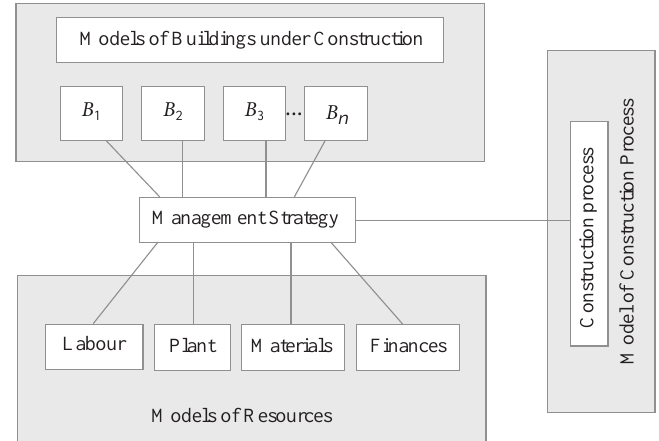
Models of Buildings under